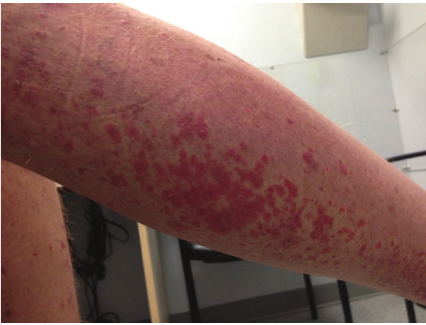
Figure1:Figureshowingpruriticscalyerythematousrashonhands.